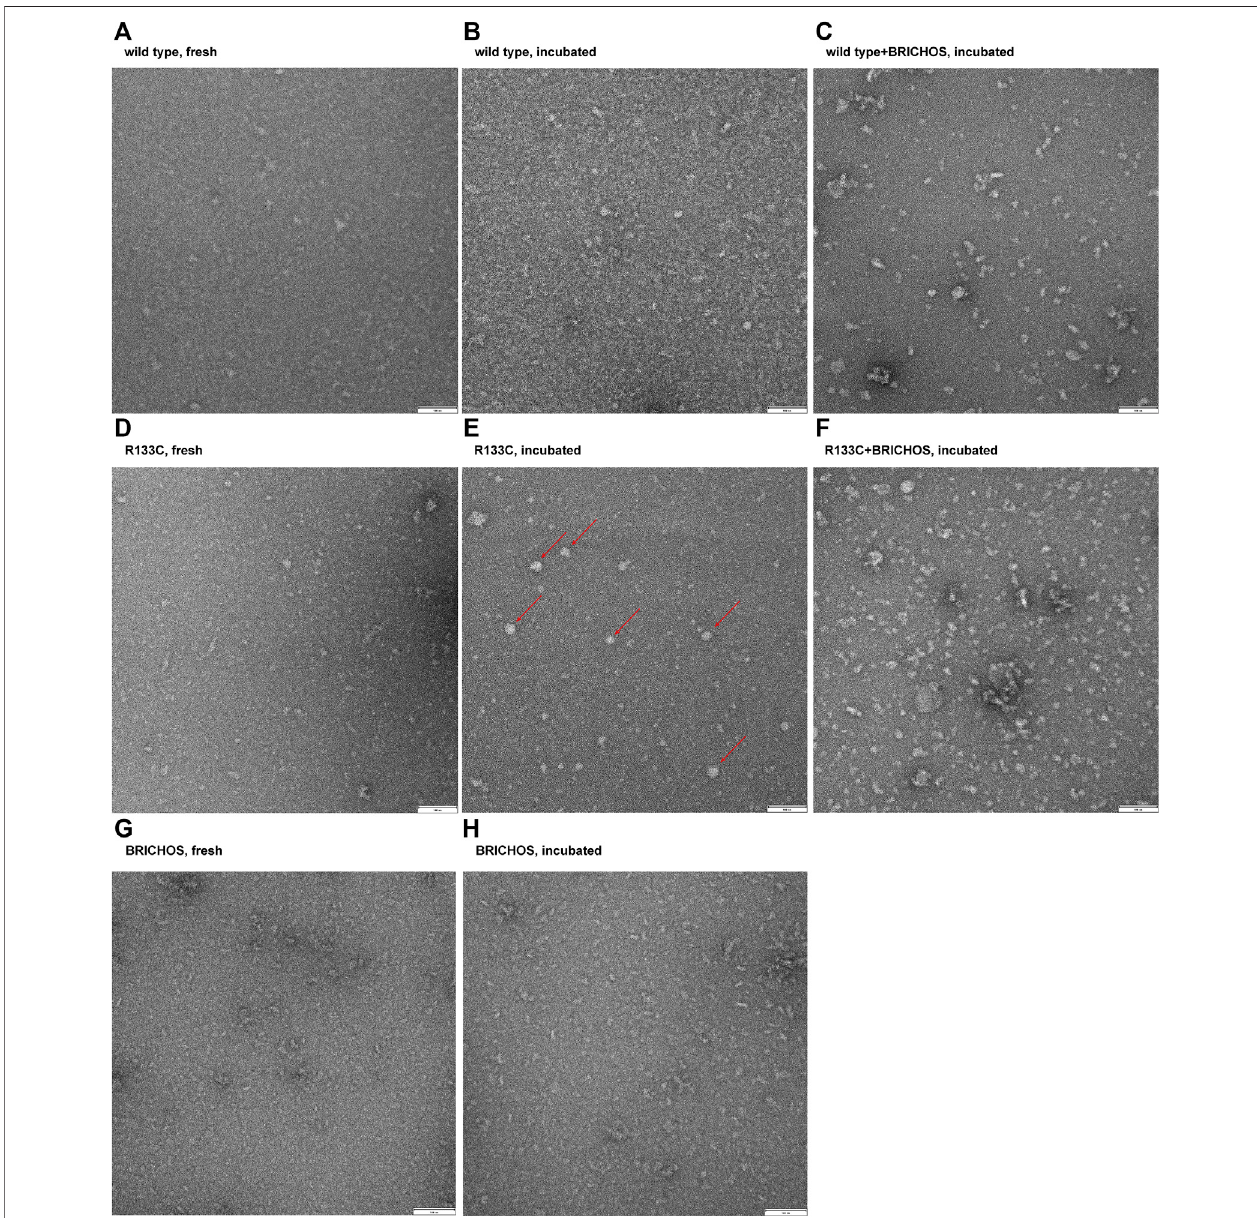
FIGURE6| ImagingofproteinparticlesofwildtypeN3EGF 1 – 5 andR133Cmutantbeforeandafter80 hofincubationinthepresenceorabsenceofBri2BRICHOS. The wildtypeN3EGF 1 – 5 and R133C mutantproteinswereappliedon carbon-coatedcopper grids andanalyzedwithTEM. (A) Freshwildtype N3EGF 1 – 5 . (B) Incubated wildtypeN3EGF 1 – 5 . (C) IncubatedwildtypeN3EGF 1 – 5 withBri2BRICHOS(1:1ratio). (D) FreshN3EGF 1 – 5 R133Cmutant. (E) IncubatedN3EGF 1 – 5 R133Cmutant. (F) Incubated N3 EGF 1 – 5 R133C mutant with Bri2 BRICHOS (1:1 ratio). (G) Fresh Bri2 BRICHOS. (H) Incubated Bri2 BRICHOS. The red arrows in F point to the